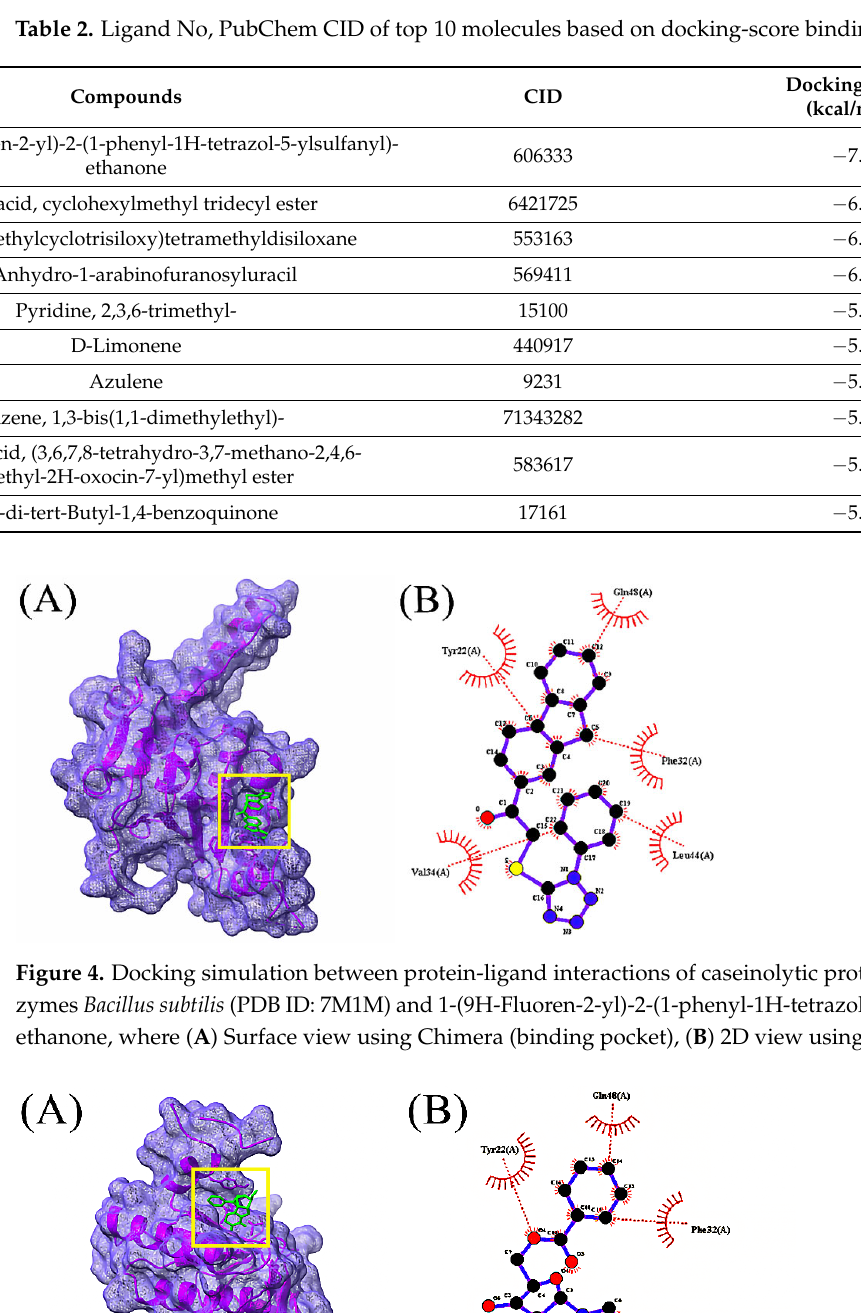
Figure 6. Docking simulation between protein ‐ ligand interactions of caseinolytic proteases (Clp) enzymes Bacillus subtilis (PDB ID: 7M1M) and bis(pentamethylcyclotrisiloxy)tetramethyldisiloxane, where ( A ) Surface view using Chimera (binding pocket), ( B ) 2D view using LigPlot+.